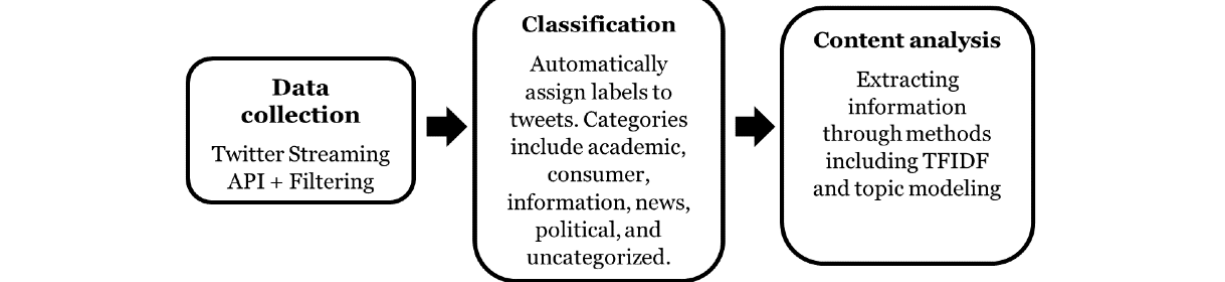
Figure 1. Workflow of the natural language processing system for automatic data collection, classification, and content analysis of the Medicaid chatter on Twitter. API: application programming interface; TFIDF: term frequency-inverse document